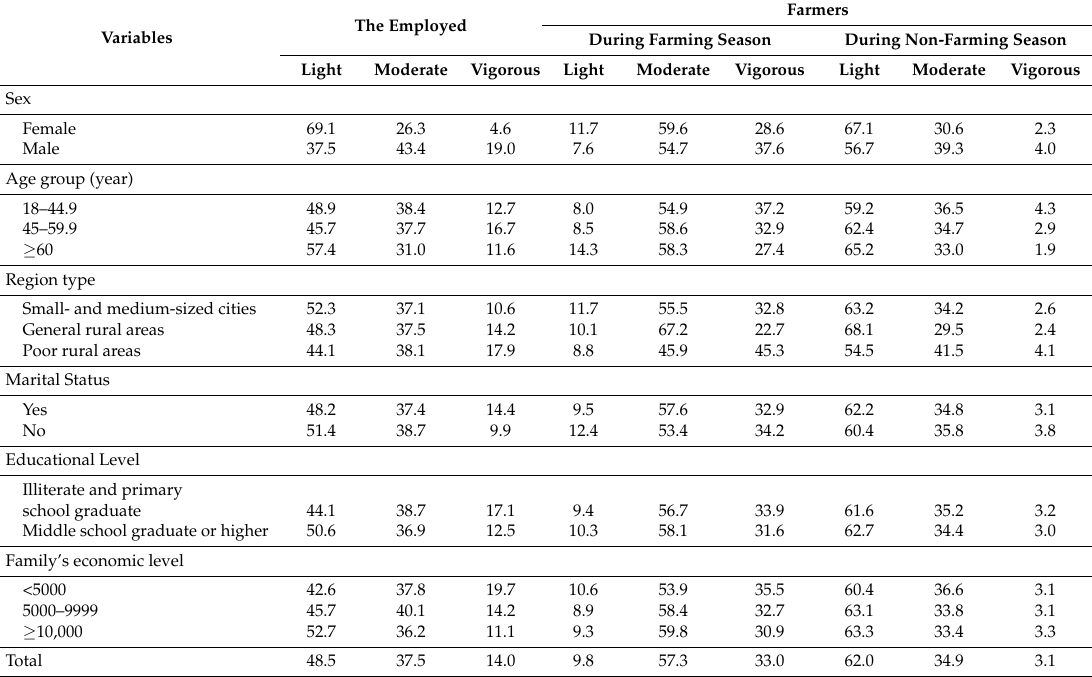
Table 3. Occupational physical activity intensity of adults stratified by occupation in rural China (%).